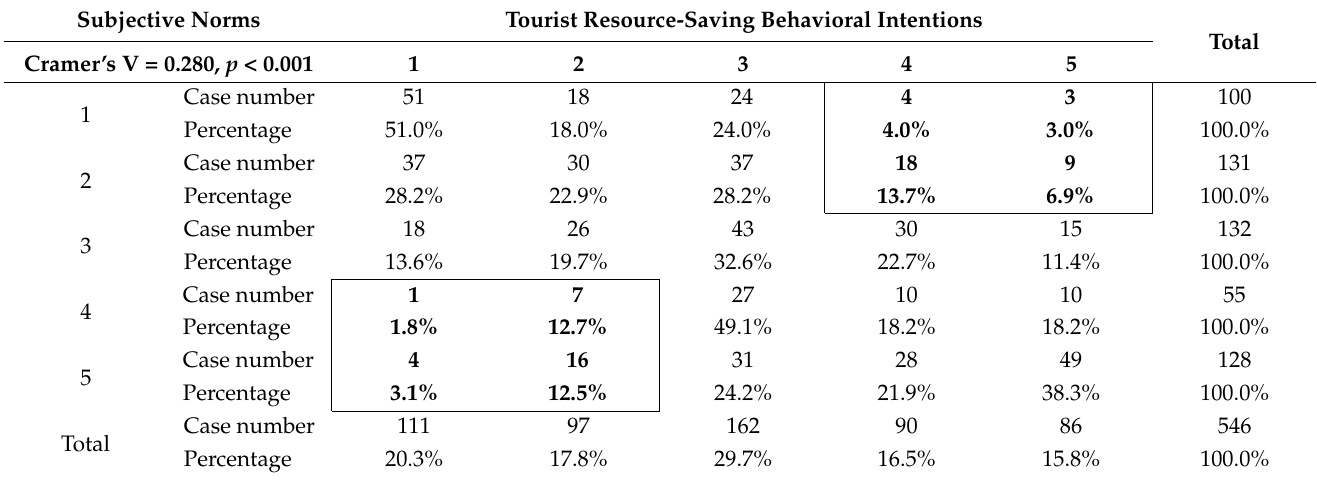
Table 6. Cross-contingency of subjective norms and tourist resource-saving behavioral intentions.